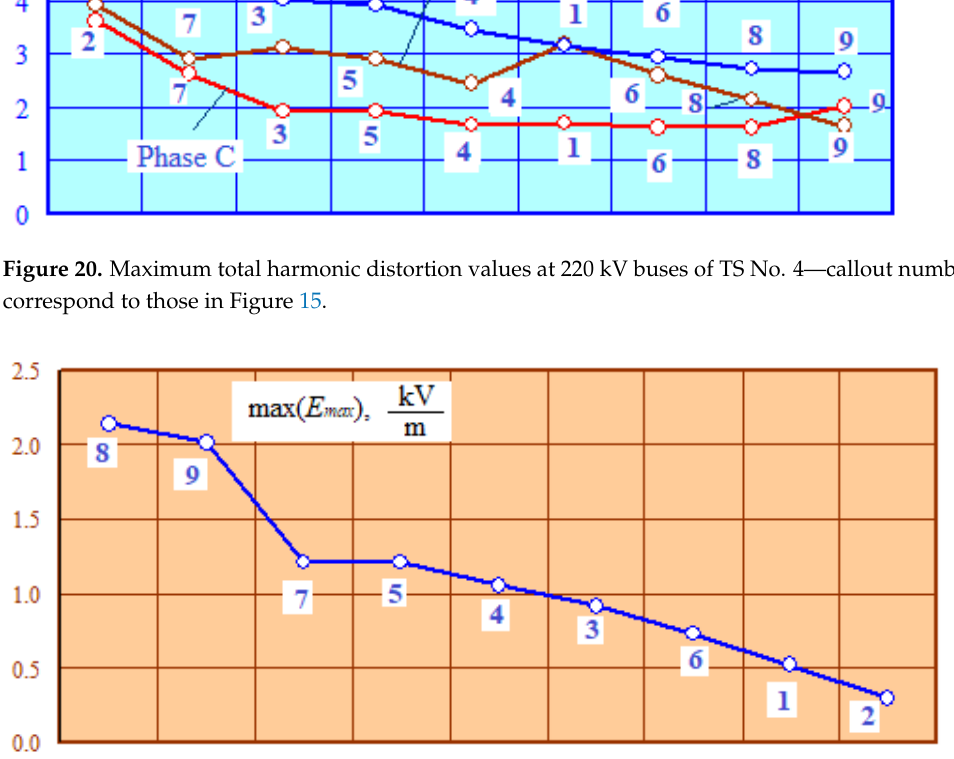
Figure 23. Coefficients of variation of amplitudes of electric field strengths: ;  is the standard deviation;